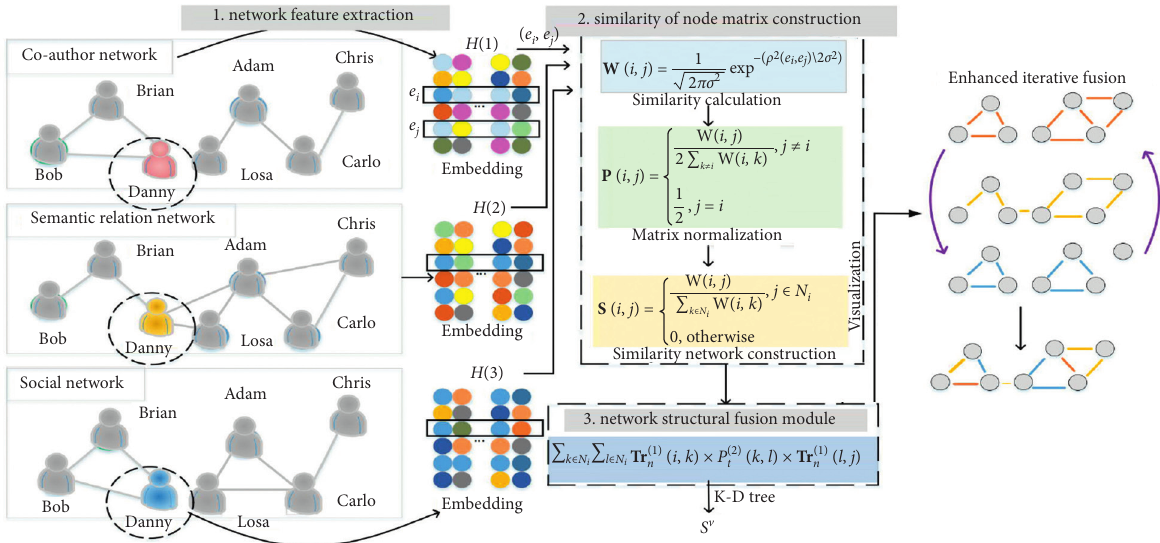
Figure 3: The architecture of MNSF for three networks as an example. Network representation learning is a node embedding process. The embedded matrices contain vectors that represent the latent representations of all nodes. Enhanced iterative fusion is a process of multiplex network